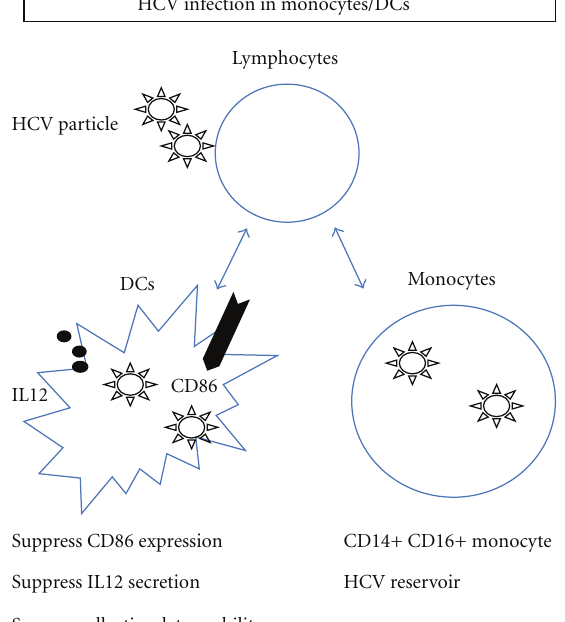
Figure 3: The schema of the biological significance of HCV replication in DCs and monocytes is shown. The representative e ff ects of lymphotropic HCV on DCs and monocytes are shown in this